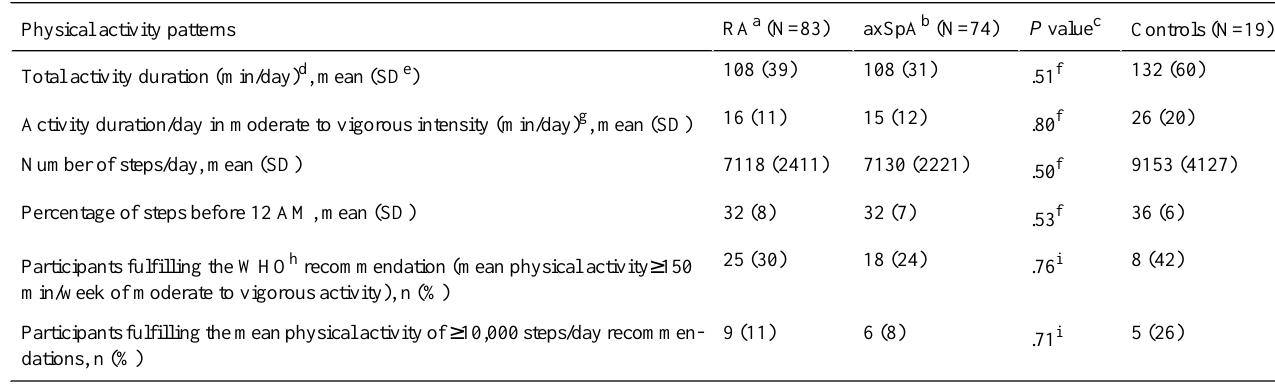
Table 2. Physical activity patterns in RA and axSpA patients.